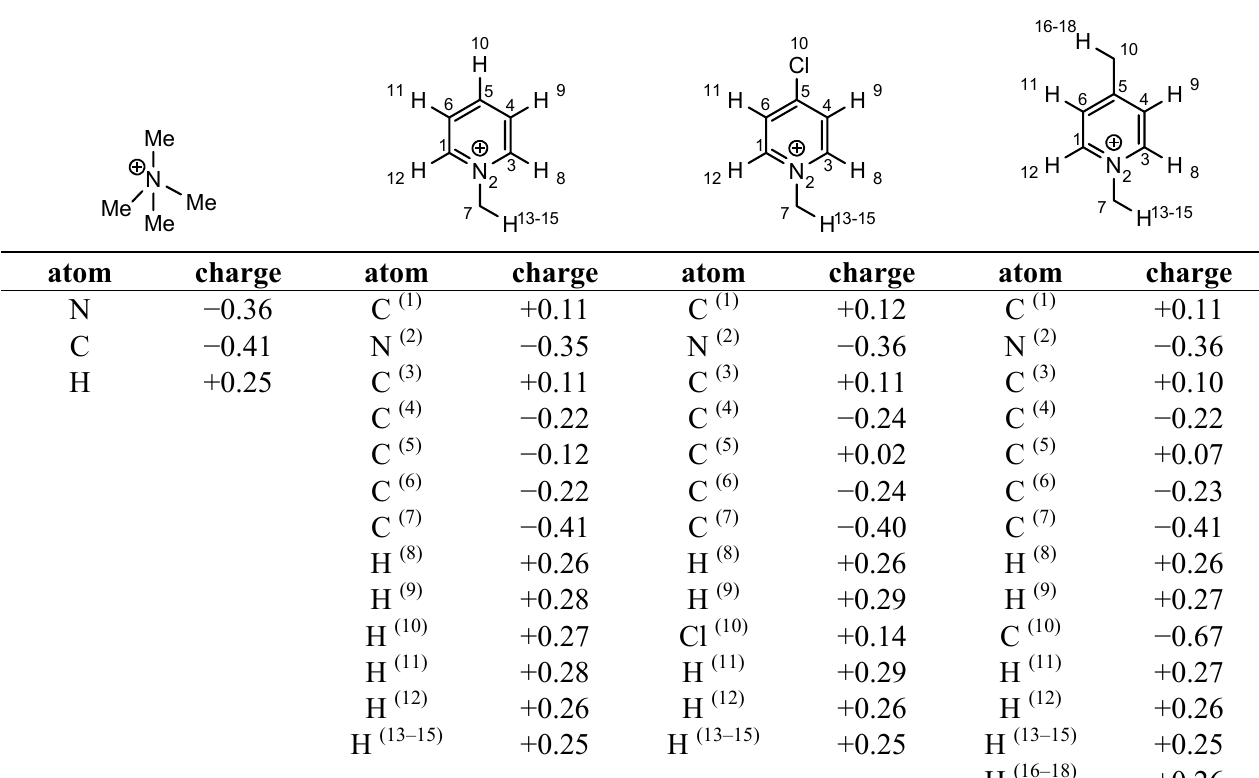
Table 4. Results of the NBO